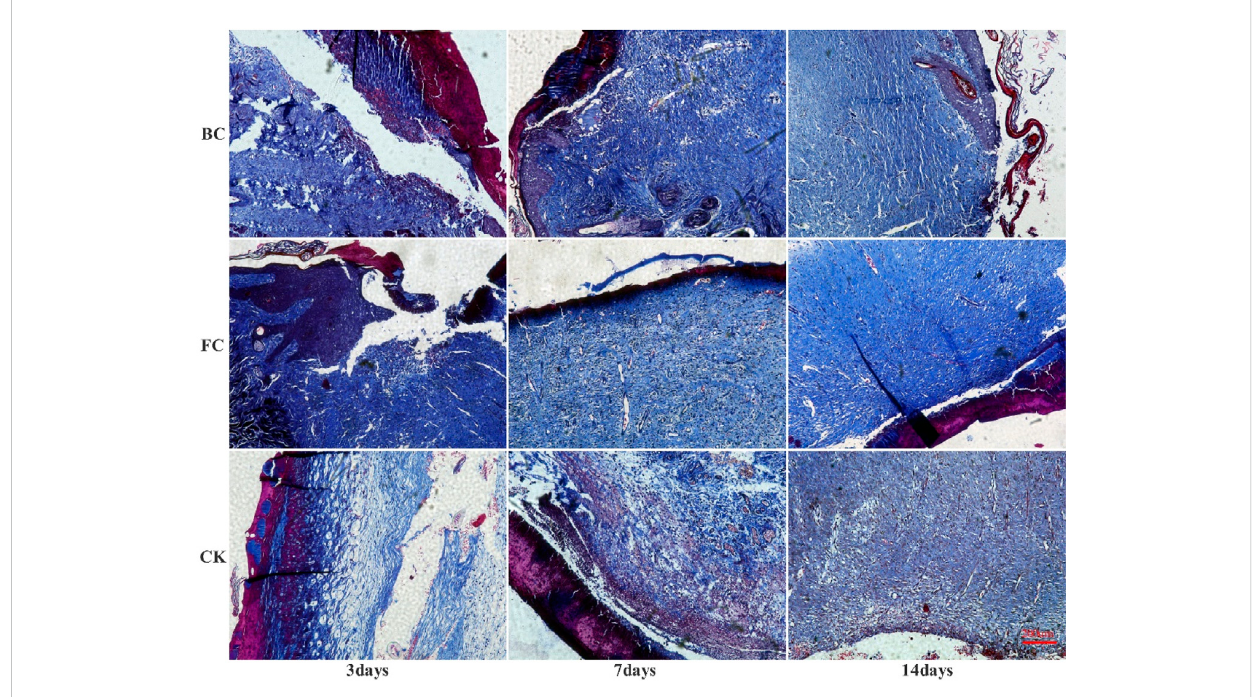
FIGURE 4 Analysis of Masson stained would tissues (Magni fi cation,